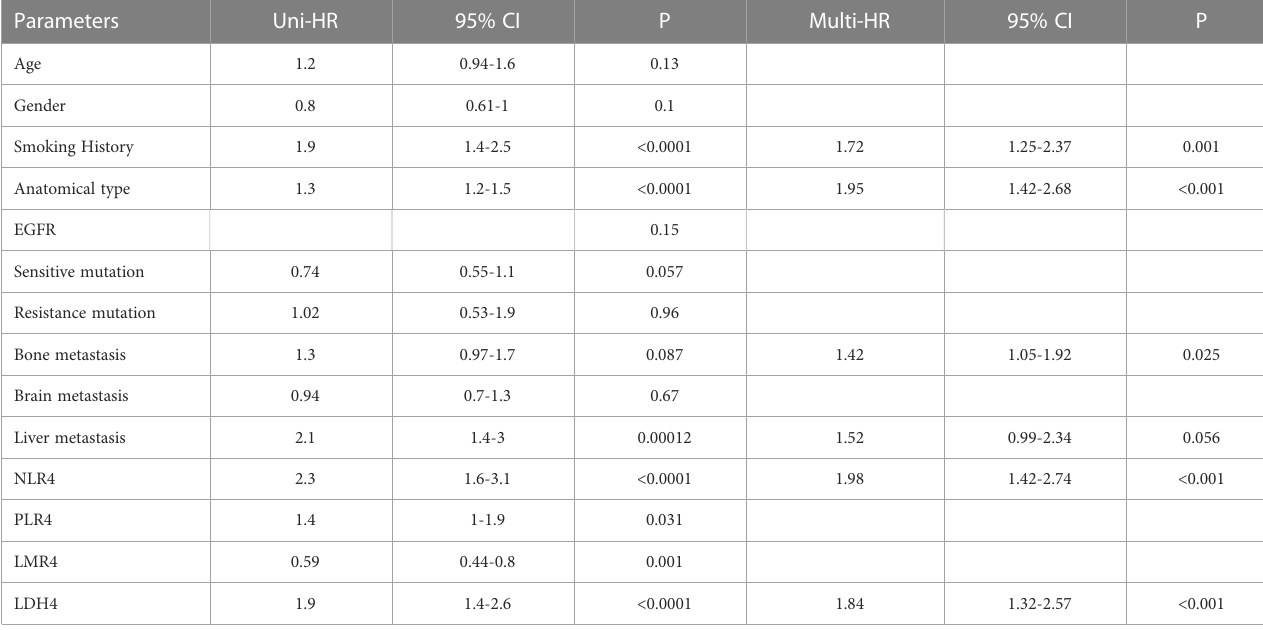
TABLE 2 Univariate and multivariate cox analysis of 272 patients.